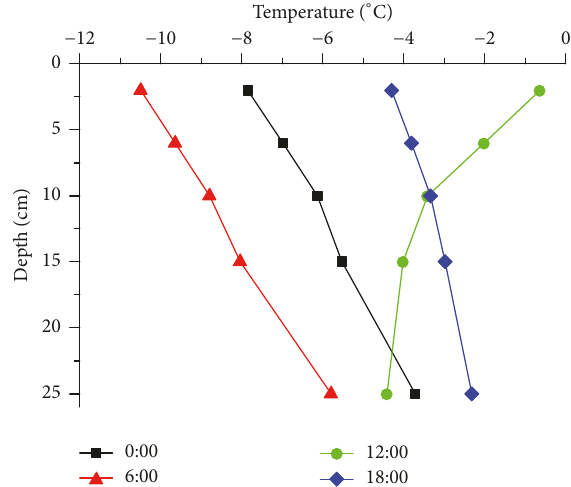
Figure 6: Normal pavement temperature in different depths.